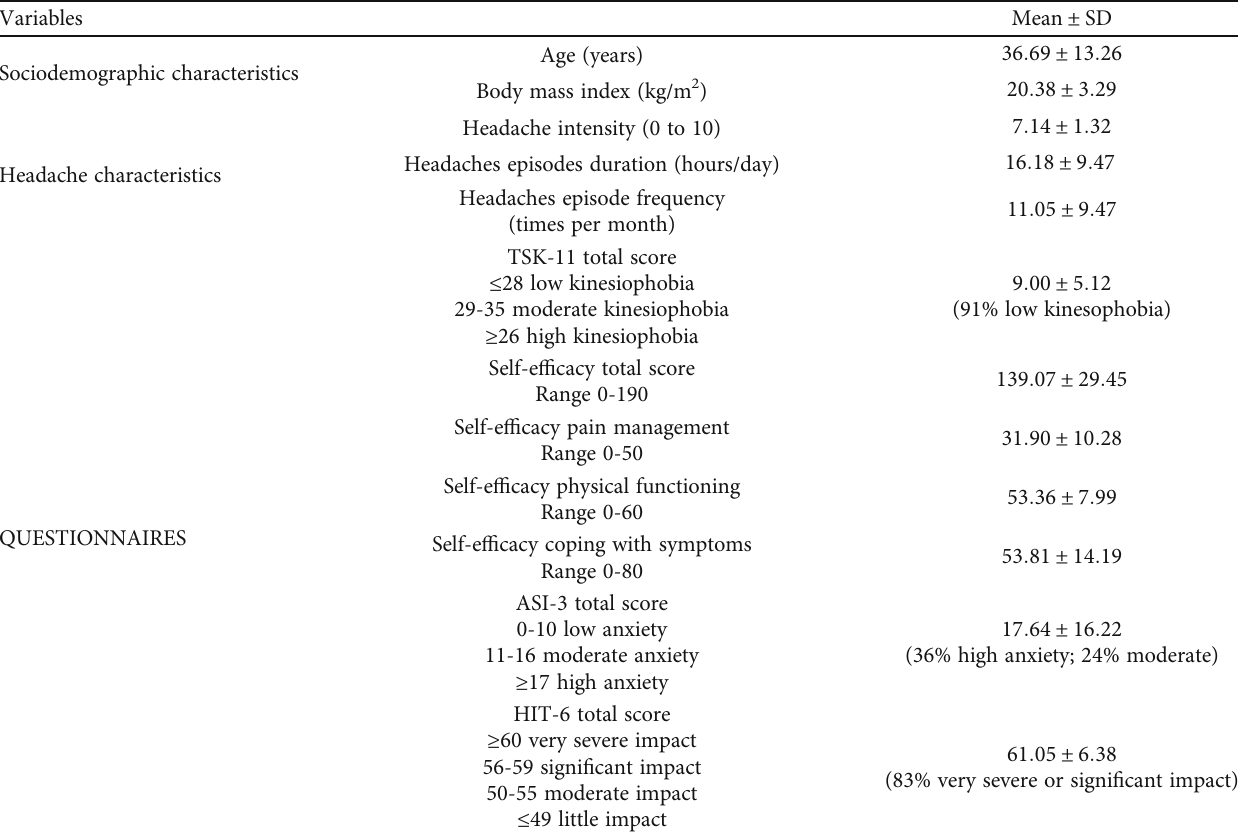
Table 1: Descriptive analysis of the variables analyzed in 42 patients with chronic tension-type headache.